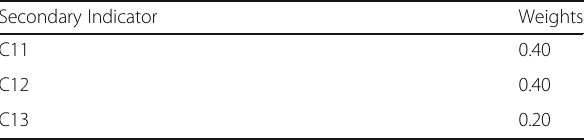
Table 16 Weights of secondary indicators under “ Others ”